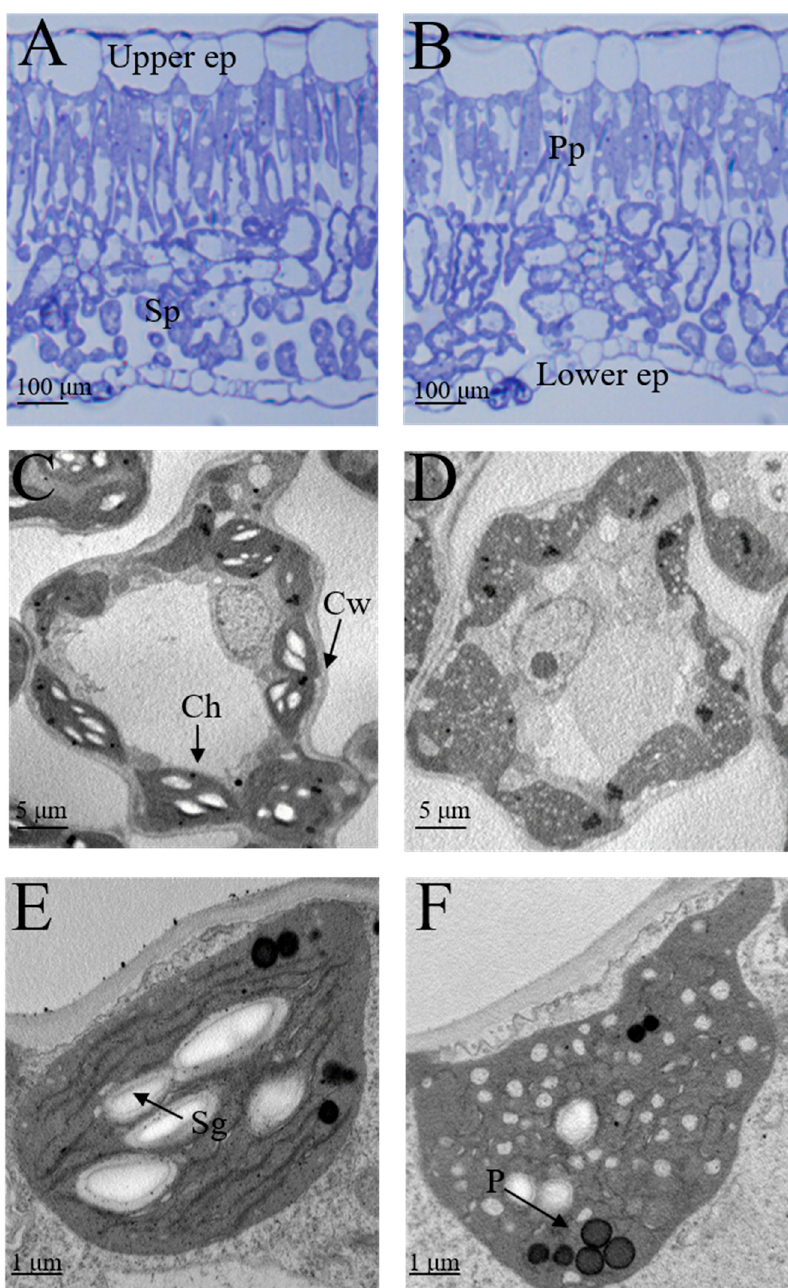
Figure 3. Semi-thin section of a cross-section of the leaves and transmission electron microscopic images of chloroplast in green and mutant leaves. ( A , B ) Cross-section of leaves from green and mutant plants. ( C , D ) Structure of mesophyll cells in green and mutant leaves. ( E , F ) Ultrastructure of the chloroplast of green and mutant leaves. Upper ep, upper epidermis; Lower ep, lower epidermis; Pp, palisade parenchyma; Sp, spongy parenchyma; Ch, chloroplast; Sg, starch granule; Cw, cell wall; P, plastoglobuli. (Scale bars: 100 μ m in ( A , B ); 5 μ m in ( C , D ); 1 μ m in ( E , F )).